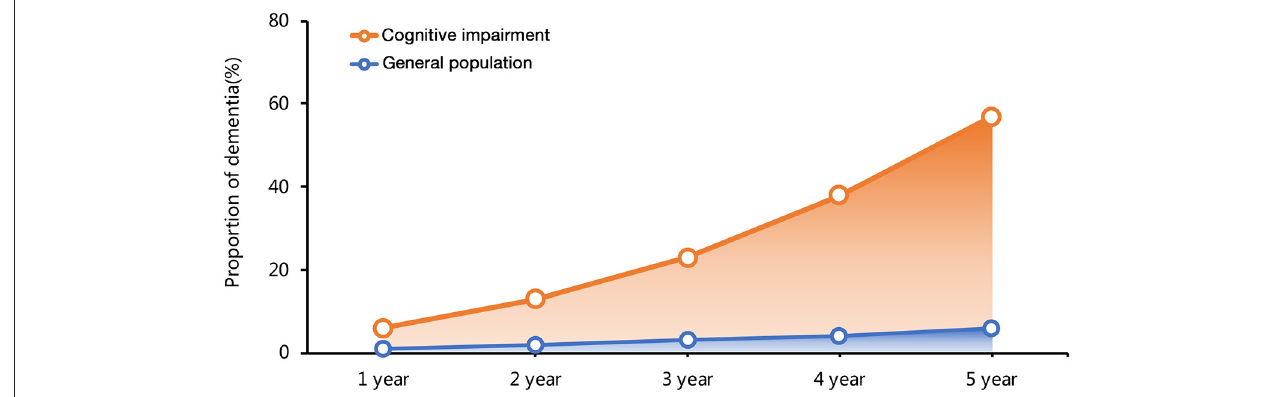
FIGURE 1 | The time curve of dementia incidence in general population and patients with cognitive impairment